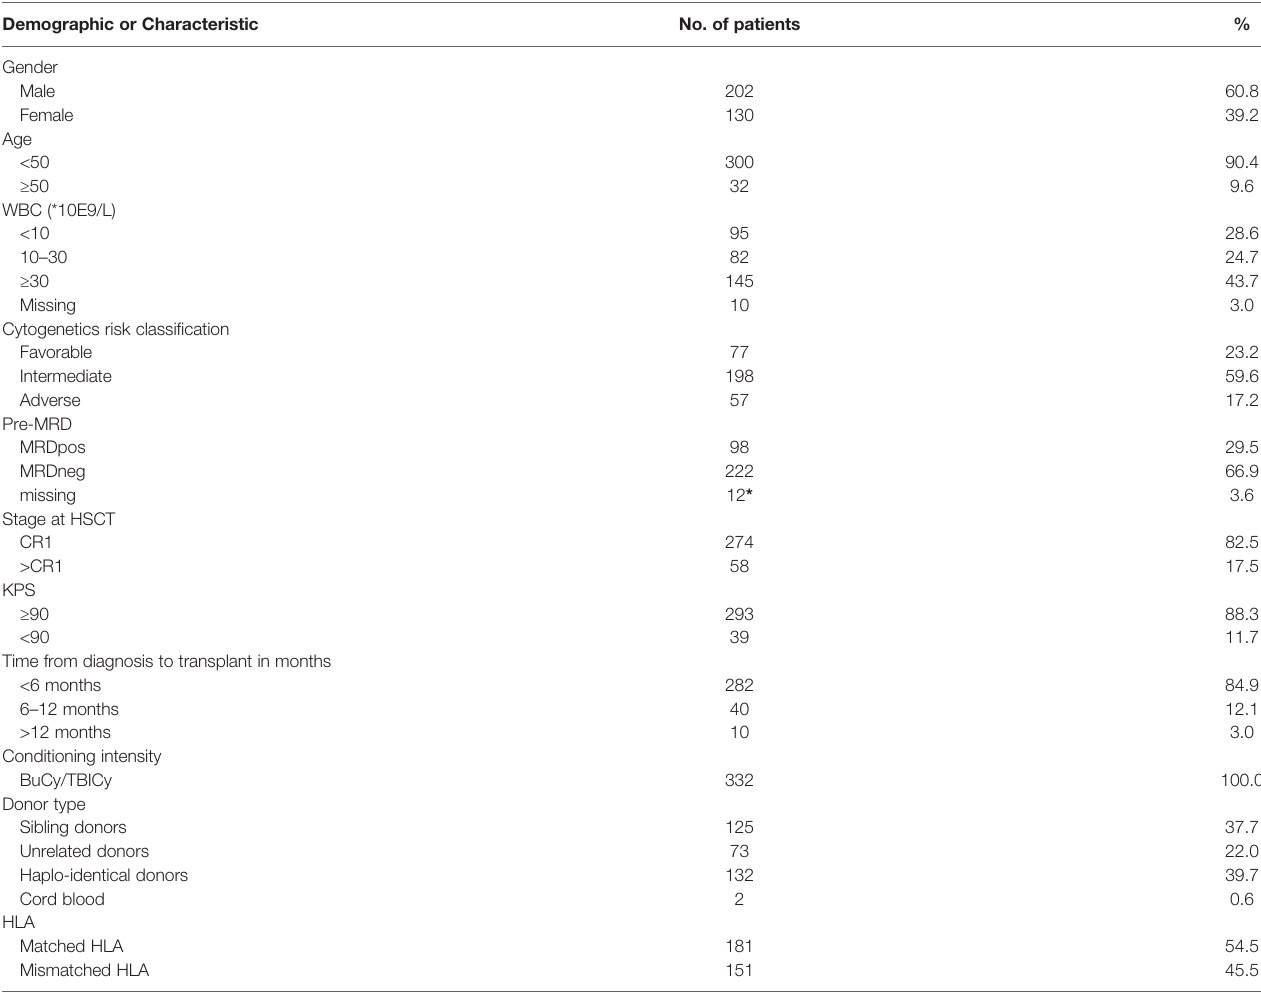
TABLE 1 | Demographic and clinicopathologic characteristics of the 332 AML patients undergoing allogeneic HSCT. Demographic or